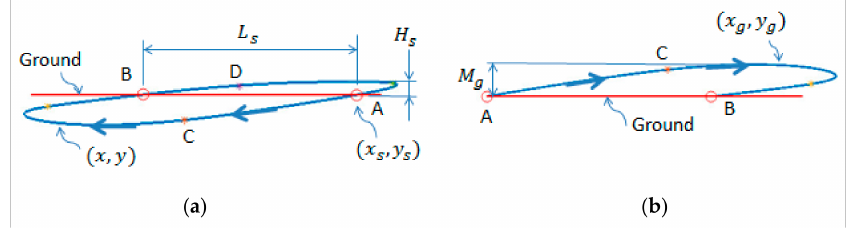
Figure 8. ( a ) Foot trajectory. ( b ) Motion of